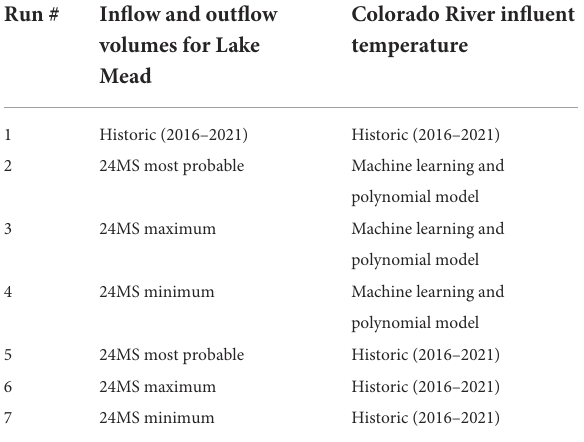
TABLE 1 Summary of LMM